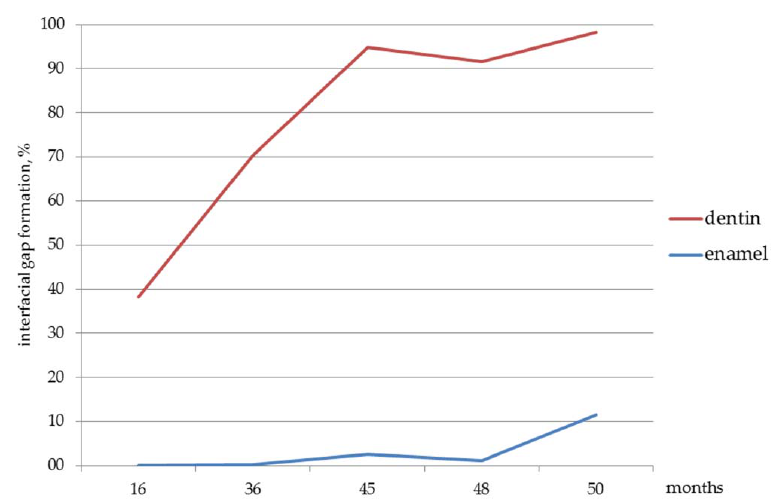
Figure 23. Percentage progression of the interfacial gap formation according to Figure 22, based on OCT cross ‐ sectional images.